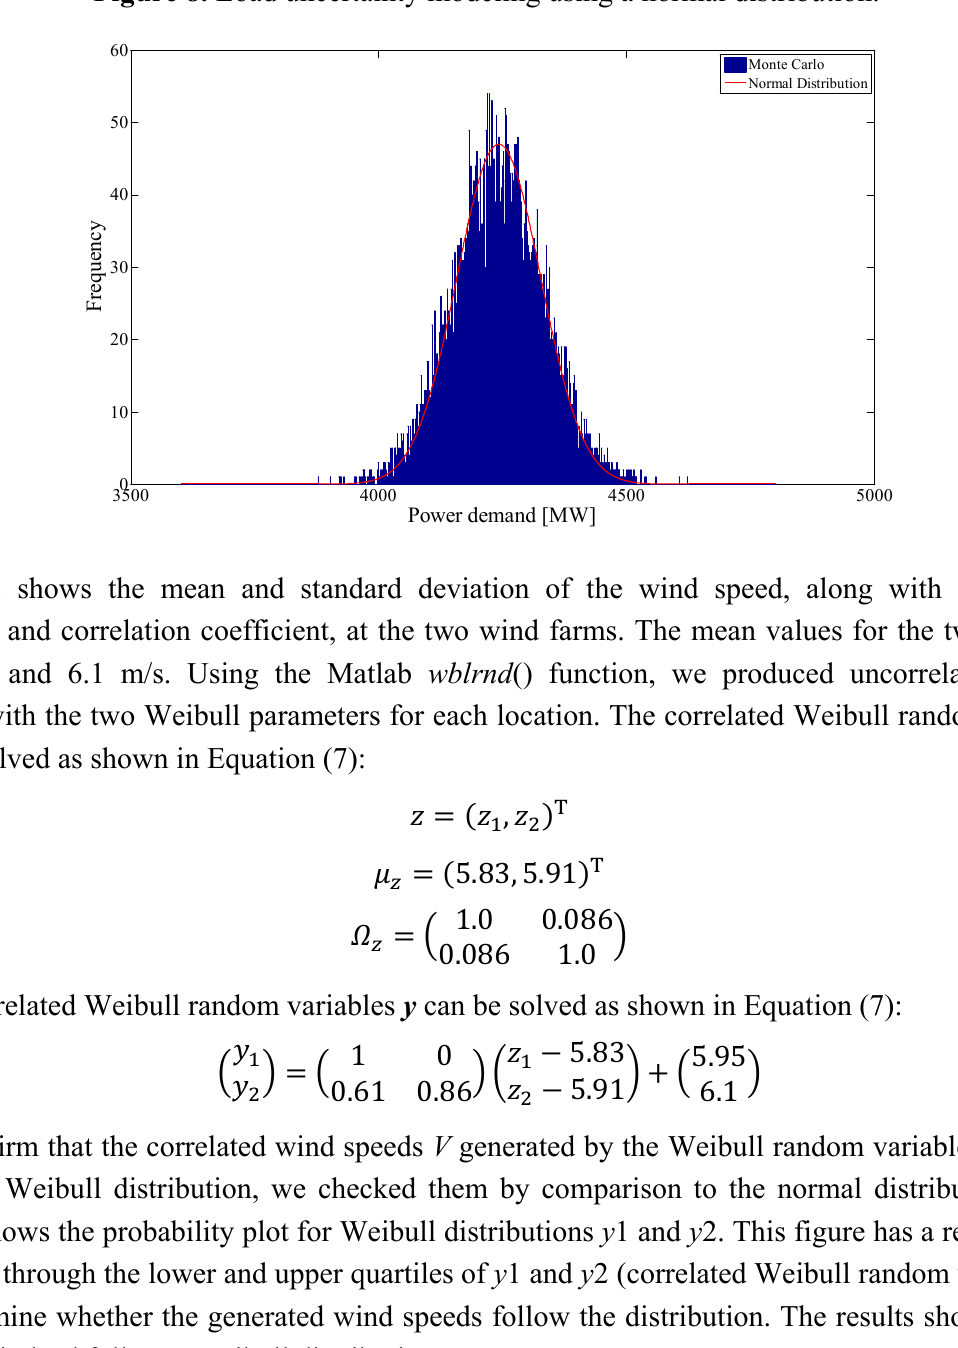
Figure 8. Load uncertainty modeling using a normal distribution.